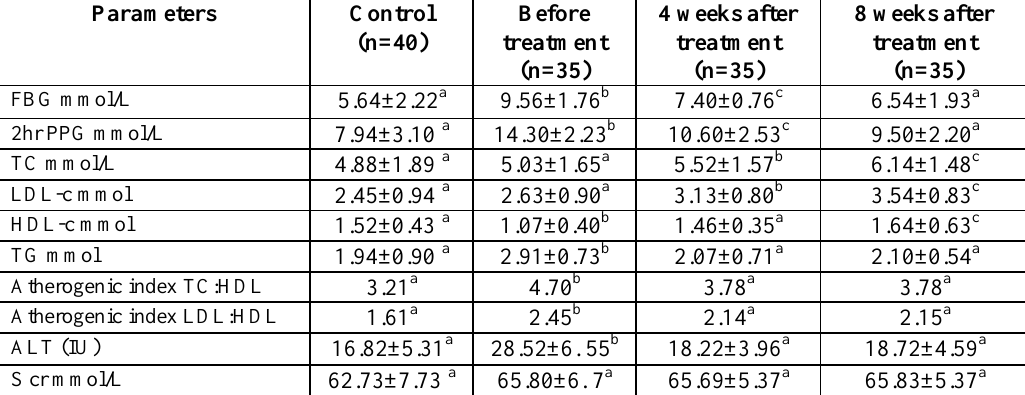
Data represented by mean ± SD.